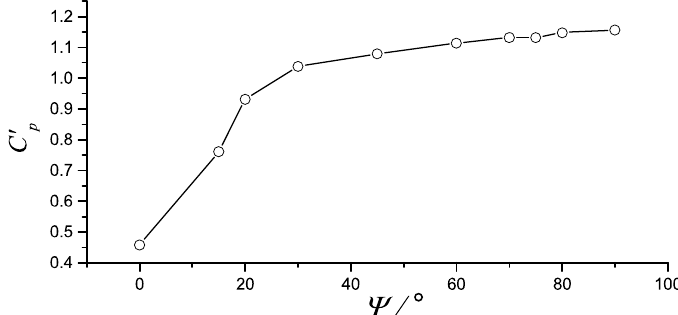
Figure 14. Influence of deflection angle on hydrodynamic characteristics of hydraulic turbine where Z = 3 and L = 4R.